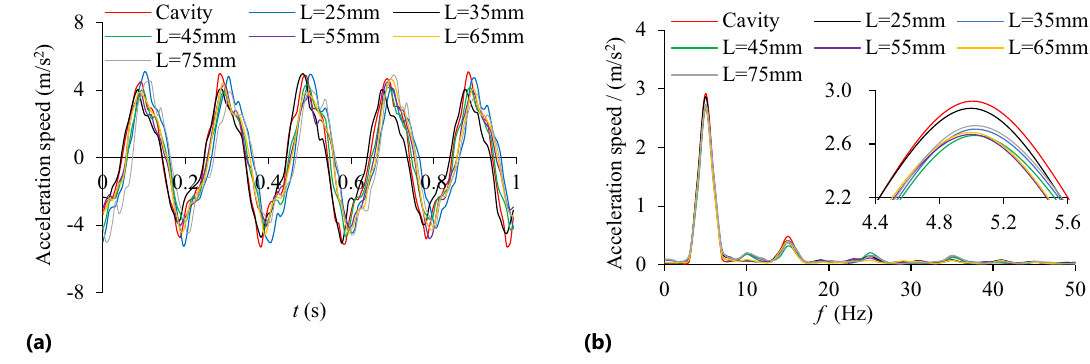
Figure 20. Acceleration speed at n = 90 r/min: (a) Time-domain; (b) Frequency domain.